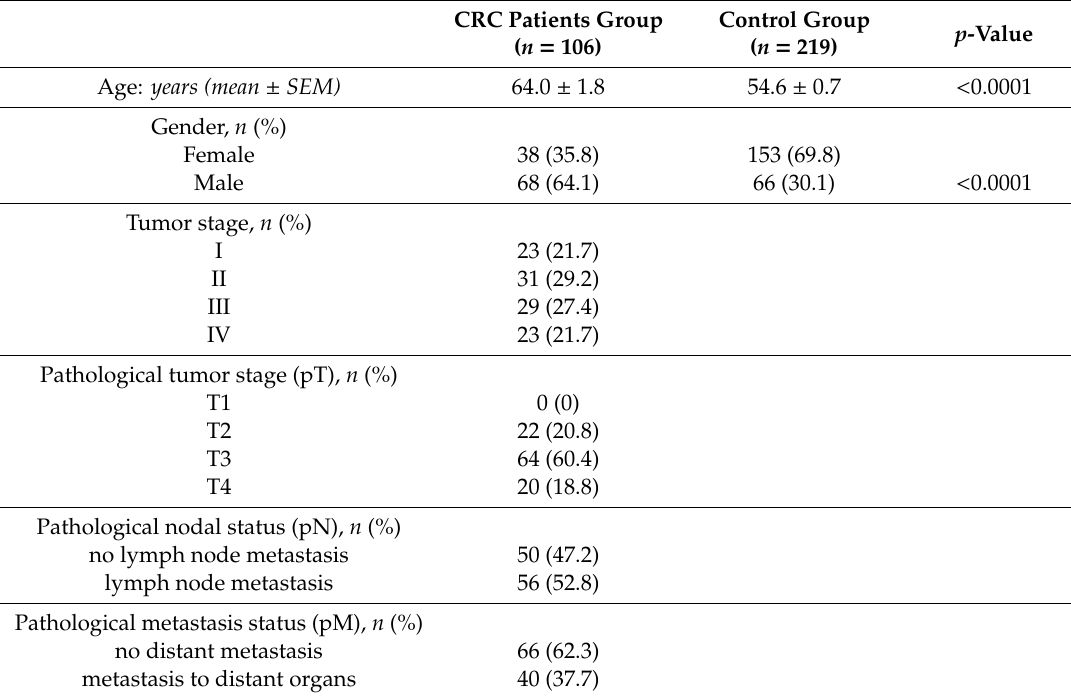
Table 1. Clinical characteristics of patients and control group. Bracket numbers indicate the percentage of patients relative to the total study